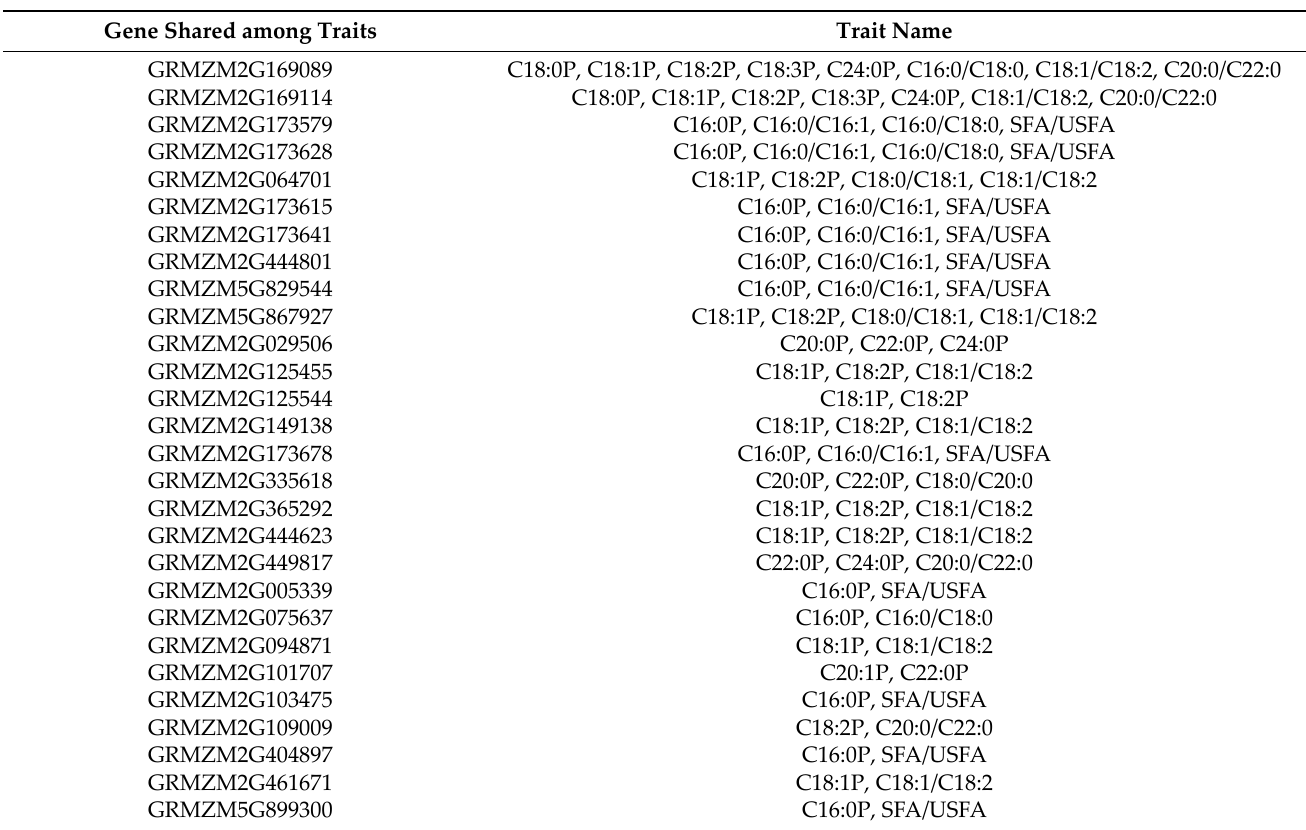
Table 2. QTGs shared among HAU traits.